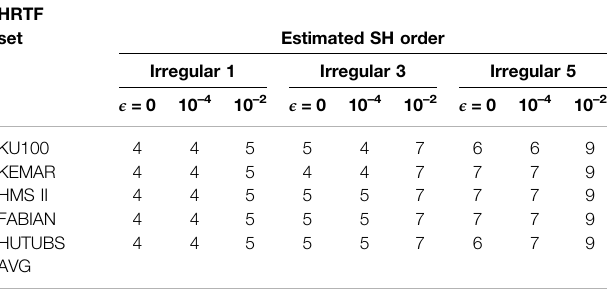
TABLE 1 | Estimated optimal SH order for different generic HRTF sets and the averaged HUTUBS HRTF set for three examined irregular grids and different regularization values ϵ .